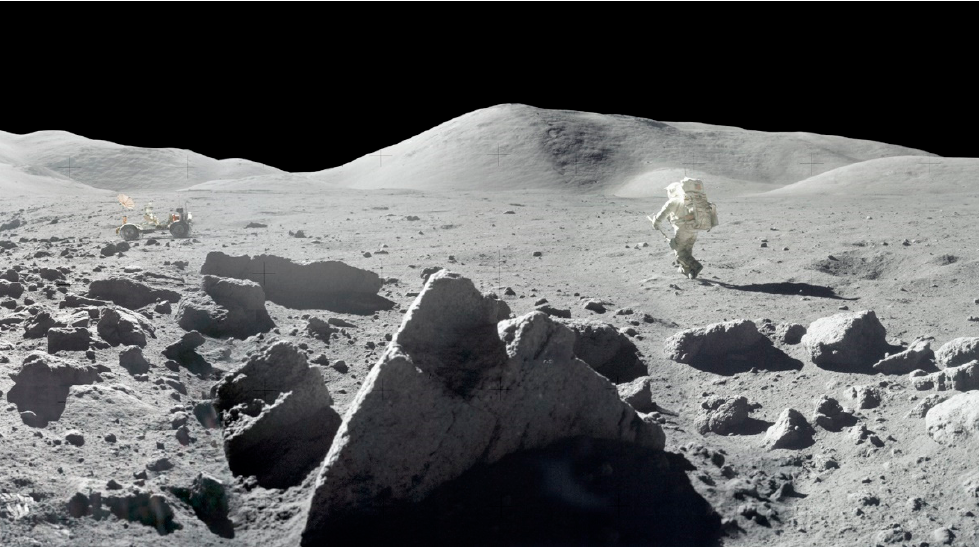
Figure 8. Collection of lunar rock samples at the Apollo 17 landing site, at an embayment in mountains at the western edge of Mare Serenitatis. (Photo mosaic from Lunar and Planetary Institute web site).